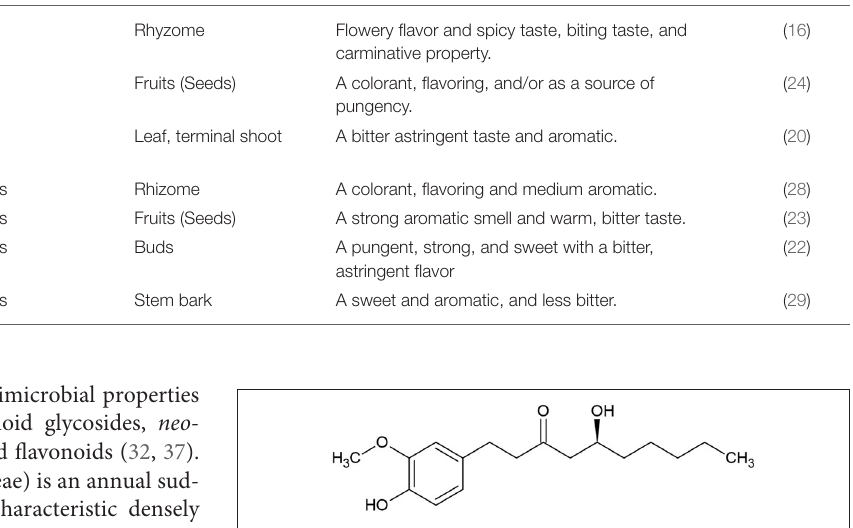
FIGURE 1 | 6-gingerol chemical